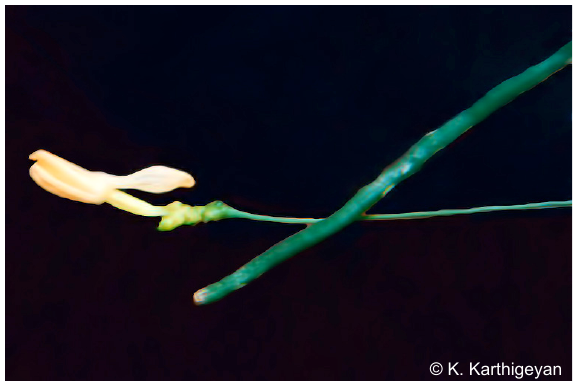
Figure 1. Taeniophyllum filiforme J.J. Sm. a - Habit; b - Flower